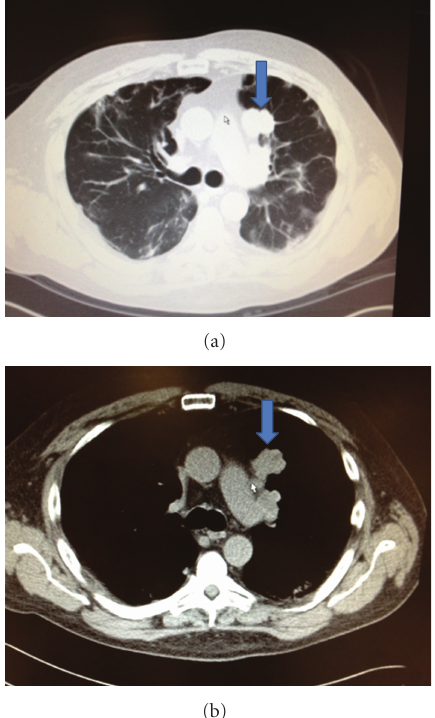
Figure 3: Chest CT with contrast that showed RCC metastasis to the left lung (blue arrow) in lung and mediastinum window.